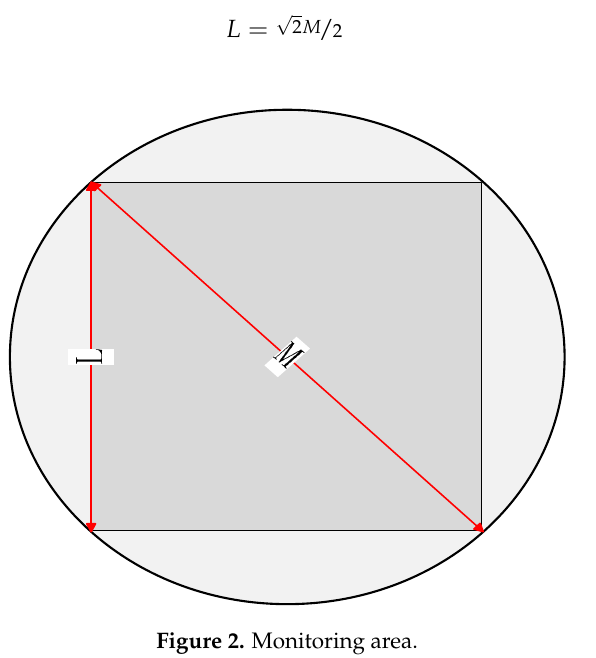
Figure 2. Monitoring area.